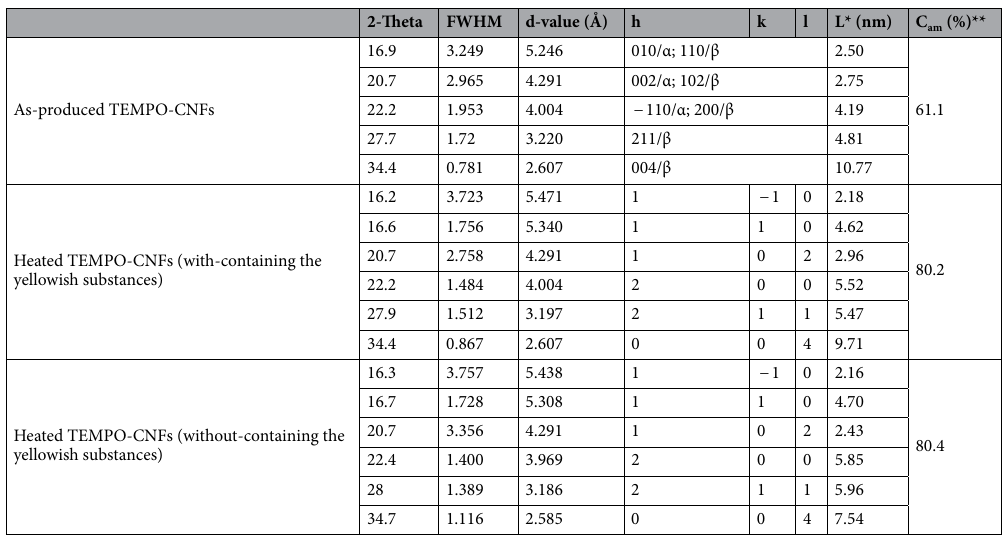
Table 1. Typical parameters selected from XRD measurements and the crystallite sizes, and the crystal/ amorphous ratios of the as-produced TEMPO-CNFs and that of the heated-TEMPO-CNFs. *Crystallite sizes were estimated based on Scherrer equation (Eq. (1)). **Crystal/amorphous ratios were calculated based on K × (cid:31) C am = I 002 − I am C am = I 200 − I am Segal method (Eq. (2) for Iα, or Eq. (3) for Iβ). L = I 002 (2). I 200 (3), where β × cos θ (1). in Eq. (1), θ, β, and λ are the Baragg’s angle, full width at half-maximum of the reflection, and wavelength of the X-ray source used, respectively; and in Eqs. (2) and (3), C am denotes the crystal/amorphous ratios, I 002 and I 200 denote the maximum intensities of diffractions of 002 (in case of Iα), and 200 (in case of Iβ), respectively, and I am is the maximum intensities of the diffraction of amorphous (2θ = 18.4). The widths were estimated to be 4.19, 5.52, and 5.85 nm, for the as-produced-TEMPO-CNFs, the heated TEMPO-CNFs with- and without- containing the yellowish substance, respectively, based on the XRD data.